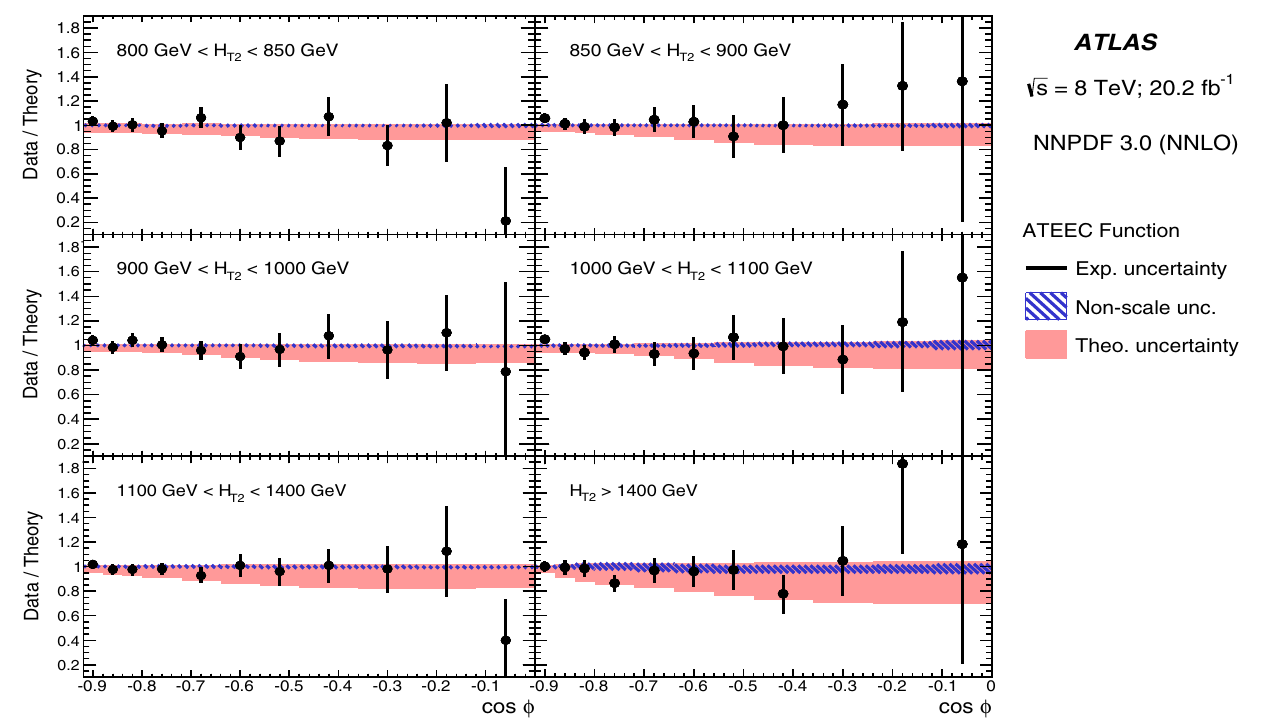
Fig. 7 Ratios of the ATEEC data in each H T2 bin to the NLO pQCD predictions obtained using the NNPDF 3.0 parton distribution functions, and corrected for non-perturbative effects Table 2 Values of the strong coupling constant at the Z boson mass scale, α s ( m Z ) obtained from fits to the TEEC function for each H T2 interval using the NNPDF 3.0 parton distribution functions. The val- ues of the average scale (cid:4) Q (cid:5) for each energy bin are shown in the first